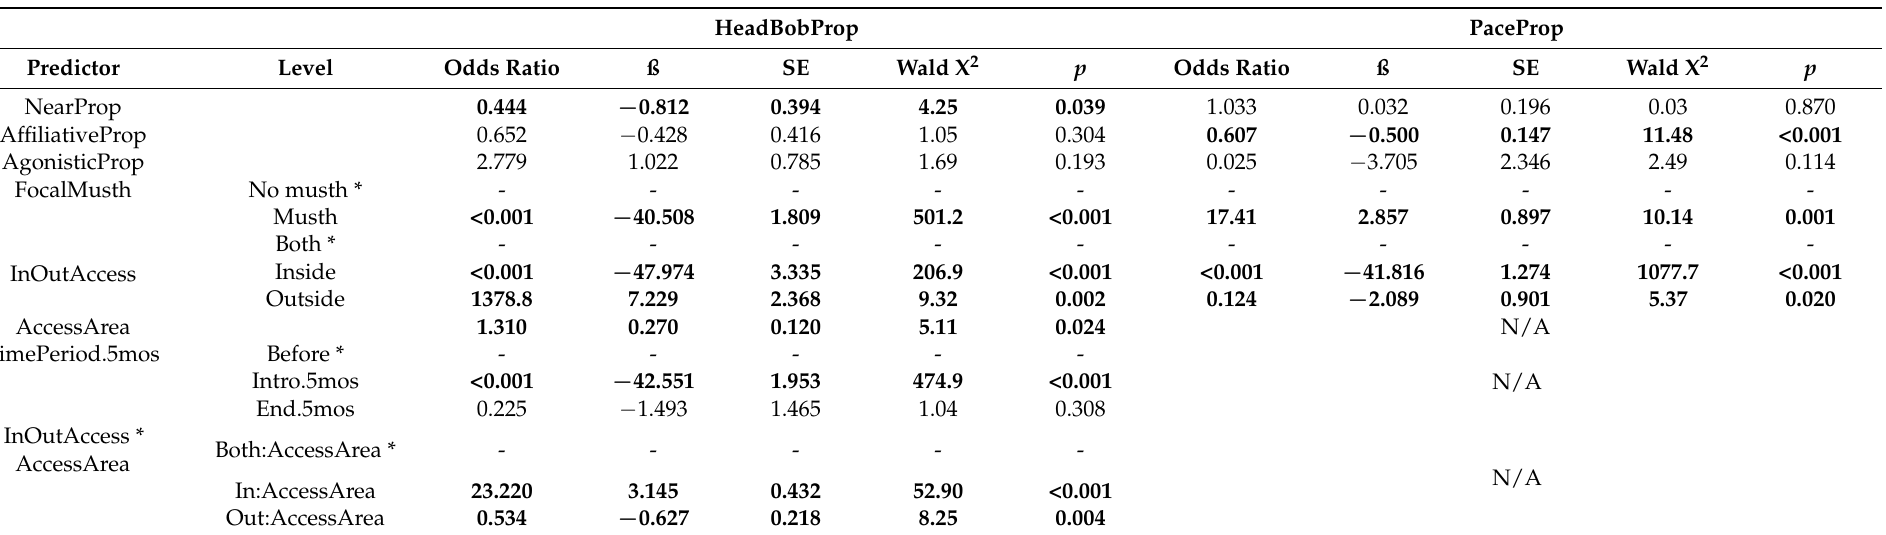
Table 7. GEE Model Parameter Estimates for Social Data. Generalized Estimating Equation Results of Associations between Predictor Variables (Fixed Effects) and Stereotypic Behavioral Response